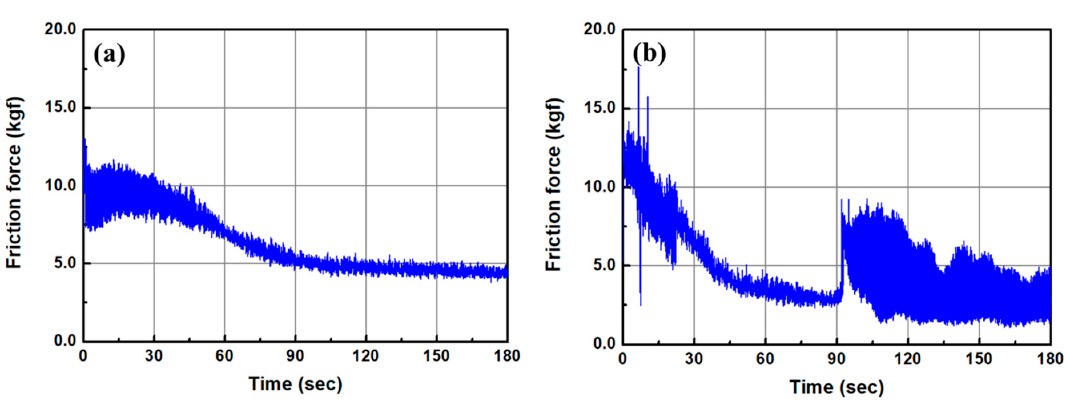
Figure 17. Schematic diagram of the two-step polishing mechanism.